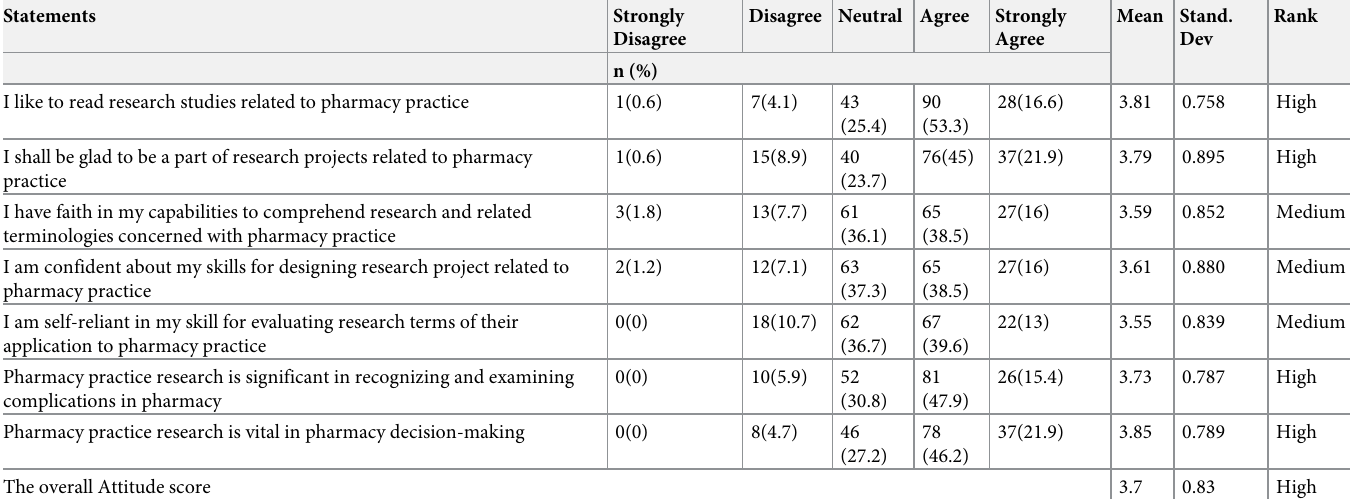
dence in daily pharmacy practice has been reported among pharmacists in different practice Table 2. Descriptive statistics of pharmacists attitudes toward practice-based research (n =